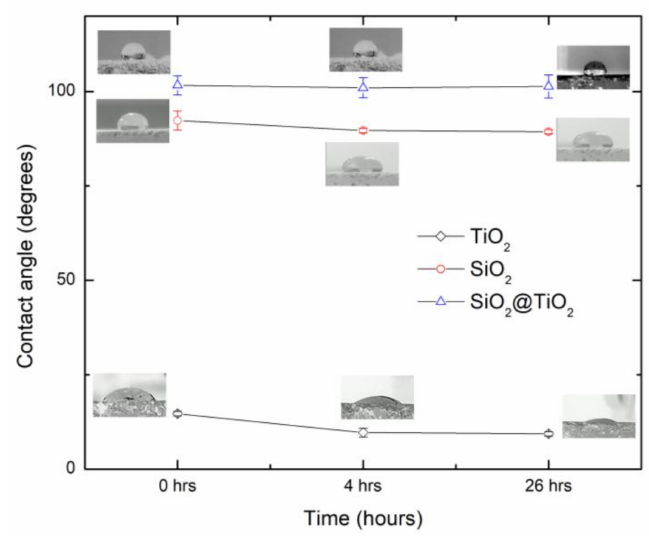
Figure 11. Water contact angles of TiO 2 , SiO 2 and SiO 2 @TiO 2 coated mortar samples before (0 h) and under UV-A irradiation (4 and 26 h). Table 3. Test of adherence results of the coated mortar samples using TiO 2 , SiO 2 and SiO 2 @TiO 2 . Coated